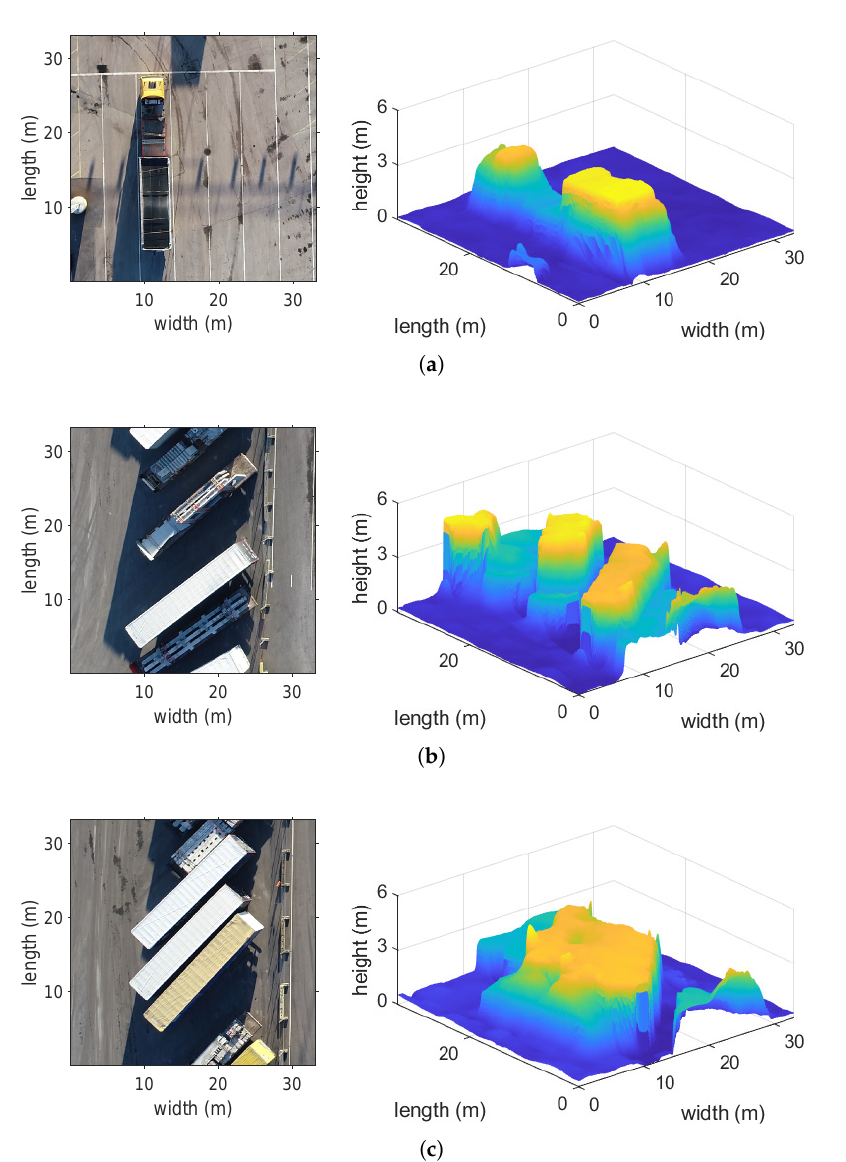
Figure 7. Examples of generated 3D feature maps under different scenarios: ( a ) single object; ( b ) multiple objects; ( c ) dense multiple